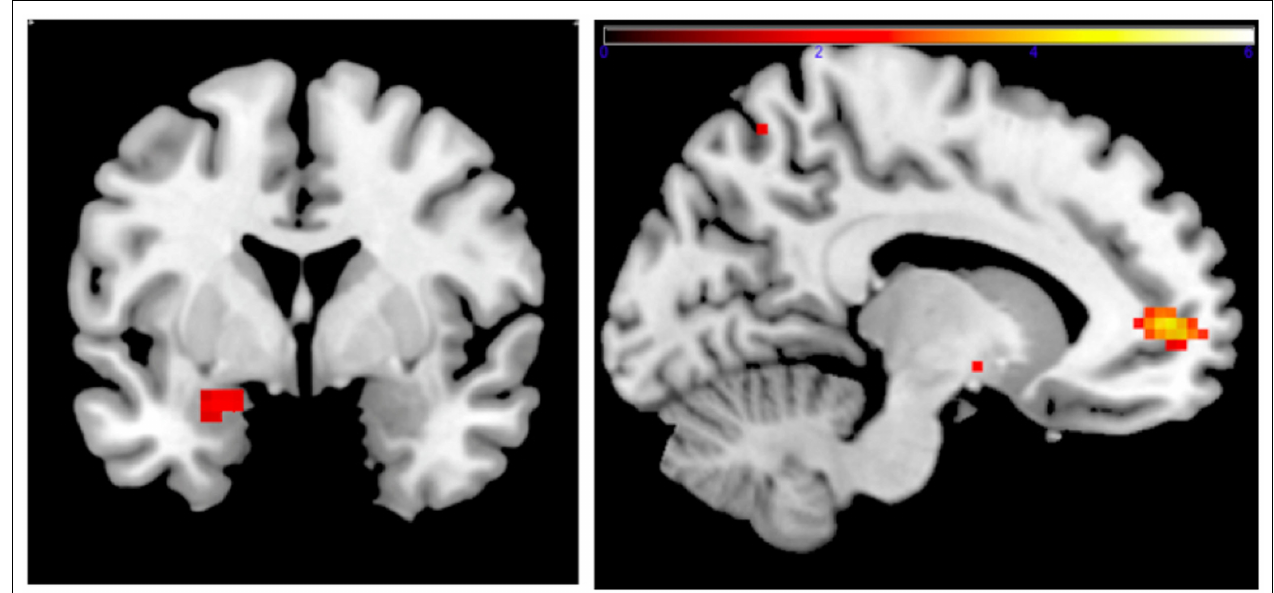
Masks are created from MNI anatomical atlas. Correlations are negative. Small volume corrections were done for all the ROIs in all the three contrasts. Only significant findings (P < 0.05) are reported in the table.